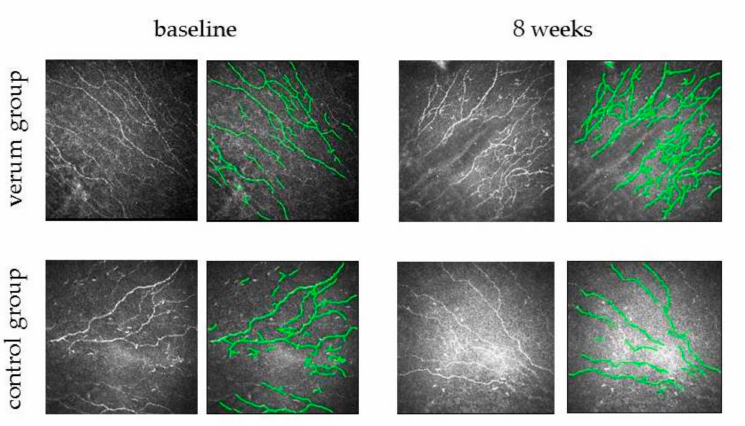
Figure 2. Typical SNP images of subjects from the control and study group, as well as a schematic representation of detected nerve fibers used for characterization of the SNP at baseline and after 8 weeks of